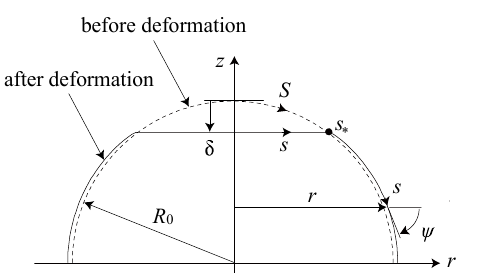
Fig.2 Geometry and coordinates of the microcapsules before and after